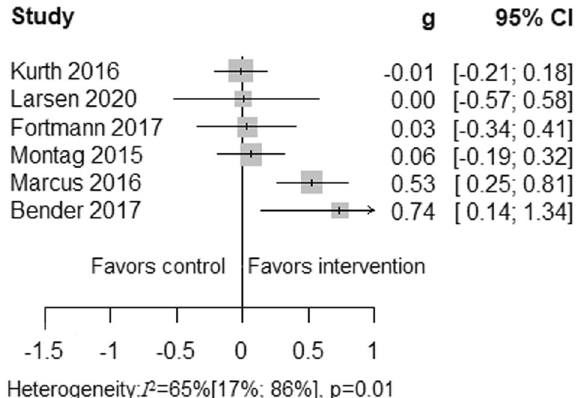
Fig. 3 Summary of culturally adapted IMI of health promotion vs. active controls in the long-term. Due to substantial heterogeneity among the culturally adapted IMI of health promotion vs. active controls in long-term meta-analytical pooling did not perform.